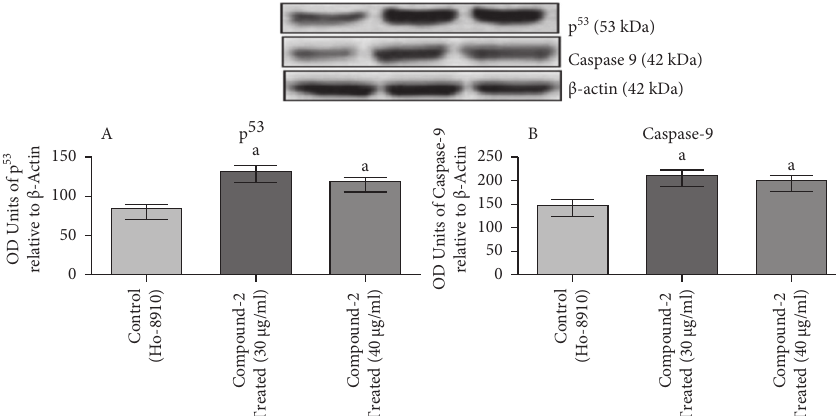
Figure 10: Effect of compound 2 on p53 and caspase-9 protein expression in HO-8910 cells. Cells were treated with 30 and 40 µ g of compound for 24h. The protein levels were quantified using the densitometry analysis and are expressed in relative intensity arbitrary unit. Each bar represents mean ± SEM of six independent observations. (a) Compared to control; (b) compared to 30 μ g of compound